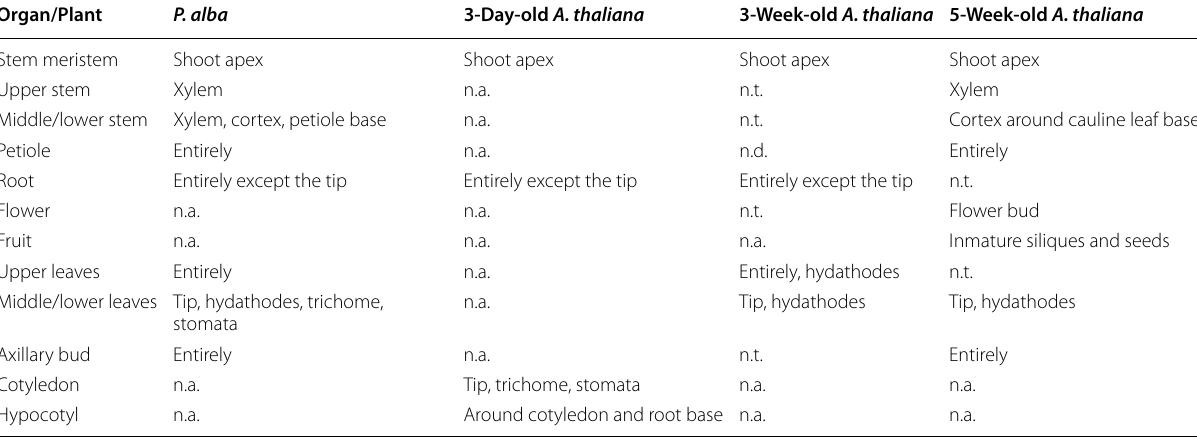
Arabidopsis data in Yoshikay‑Benitez et al.